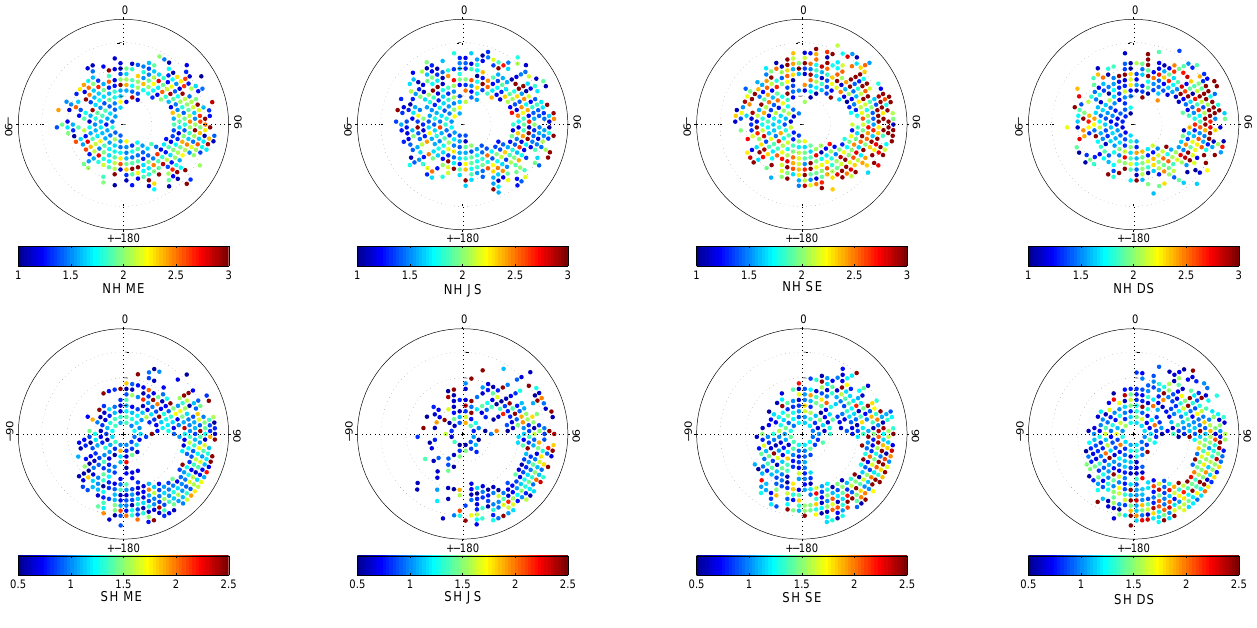
the SZA changes almost linearly with latitude. We may thus identify SZA dependences in Figure 10. Although large am- plitudes (red dots) can be found at all longitudes, there is a somewhat higher concentration at longitudes where the cusp- related area reaches down to lower geographic latitudes. This Fig. 10. The location of the density anomaly peaks in geographic coordinates separately for both hemispheres and the four seasons. Stronger anomalies are more common at lower latitudes. relation is more evident in the southern hemisphere, where we have a larger distance between geographic and geomag- netic poles.